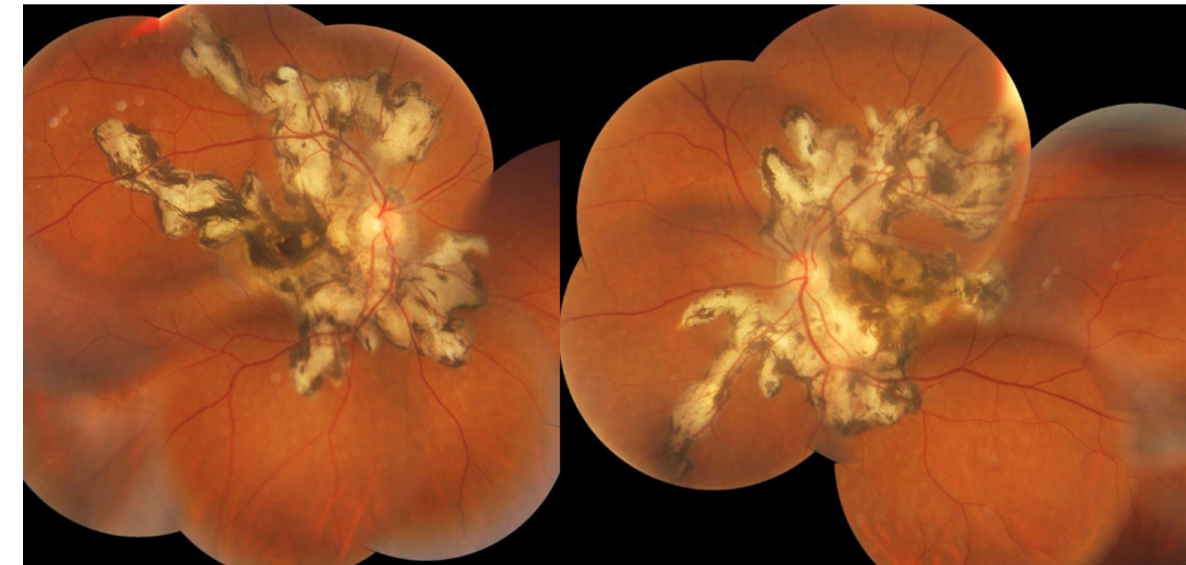
Figure 23. SC: serpiginous lesions on fundus photography. Bilateral creeping lesions typical of SC.